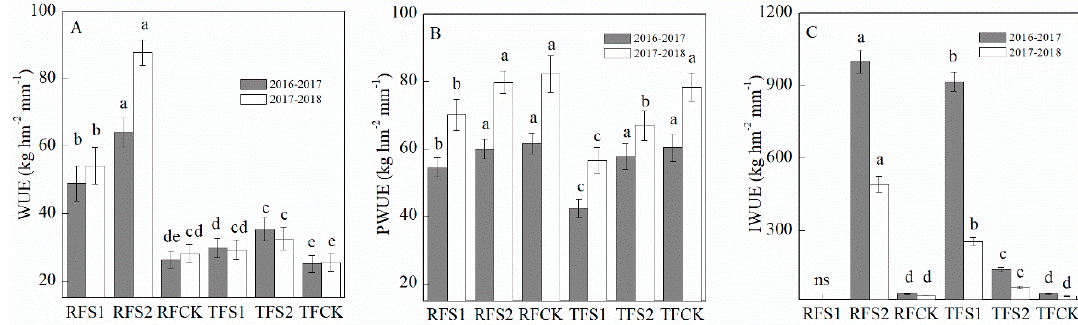
Figure 6. Effects of planting and irrigation on the water use efficiencies of wheat. A, B and C represent WUE, PWUE and IWUE, respectively. RF: plastic-covered ridge and furrow planting; TF: traditional flatten planting; S1: supplemental irrigation based on measuring soil moisture and the target relative soil water content is 85%; S2: supplemental irrigation based on measuring soil moisture and the target relative soil water content is 100%; CK: traditional irrigation. WUE: water use efficiency; IWUE: irrigation water use efficiency; PWUE: precipitation water use efficiency. Vertical bars represent ± the standard deviation of the mean ( n = 3). Values followed by different lower letters are significantly different at p = 0.05 in the same year.